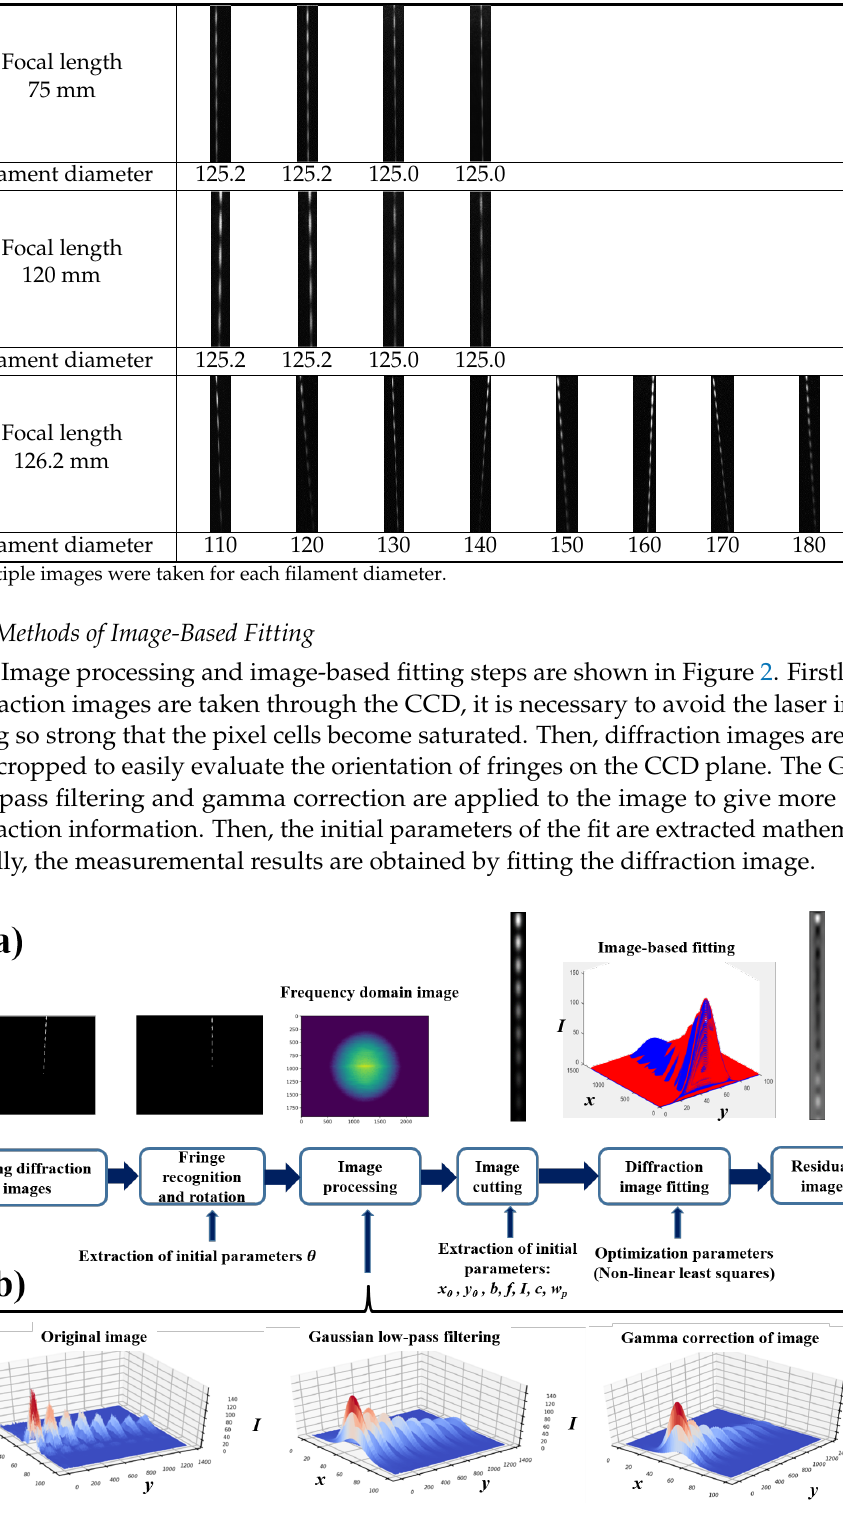
Figure 2. The detailed descriptions diagram of the method: ( a ) the procedure for fitting diffraction images; ( b ) diffraction images with filtering and gamma